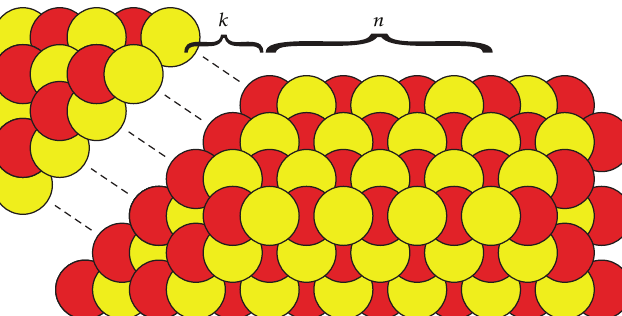
Figure 17: Factorization of the conifold pyramid which leads to open BPS generating functions. The size of the pyramid n represents the closed BPS chamber, while the size k encodes the open BPS